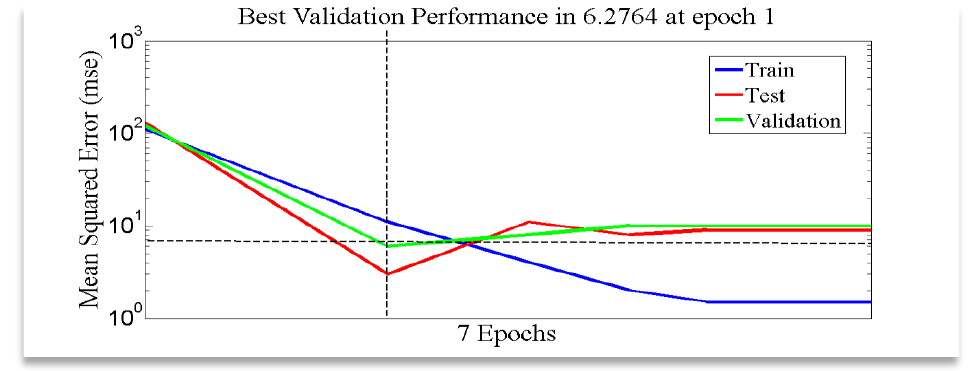
Figure 7. Training output, validation, and neural network testing .